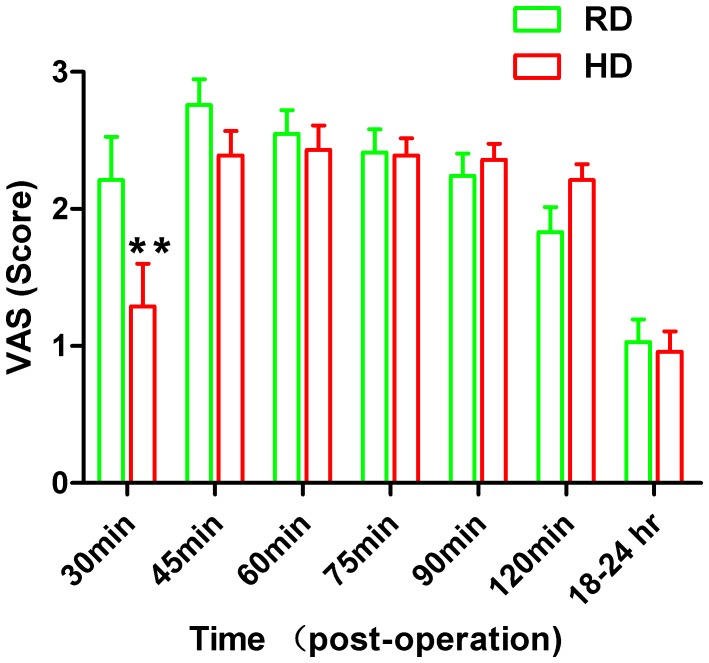
VAS scored at different times postoperatively.Note the VAS score at 30(p<0.01, Two-way ANOVA analysis followed by Bonferroni’s post hoc test). **, p<0.01, RD group vs HD group.